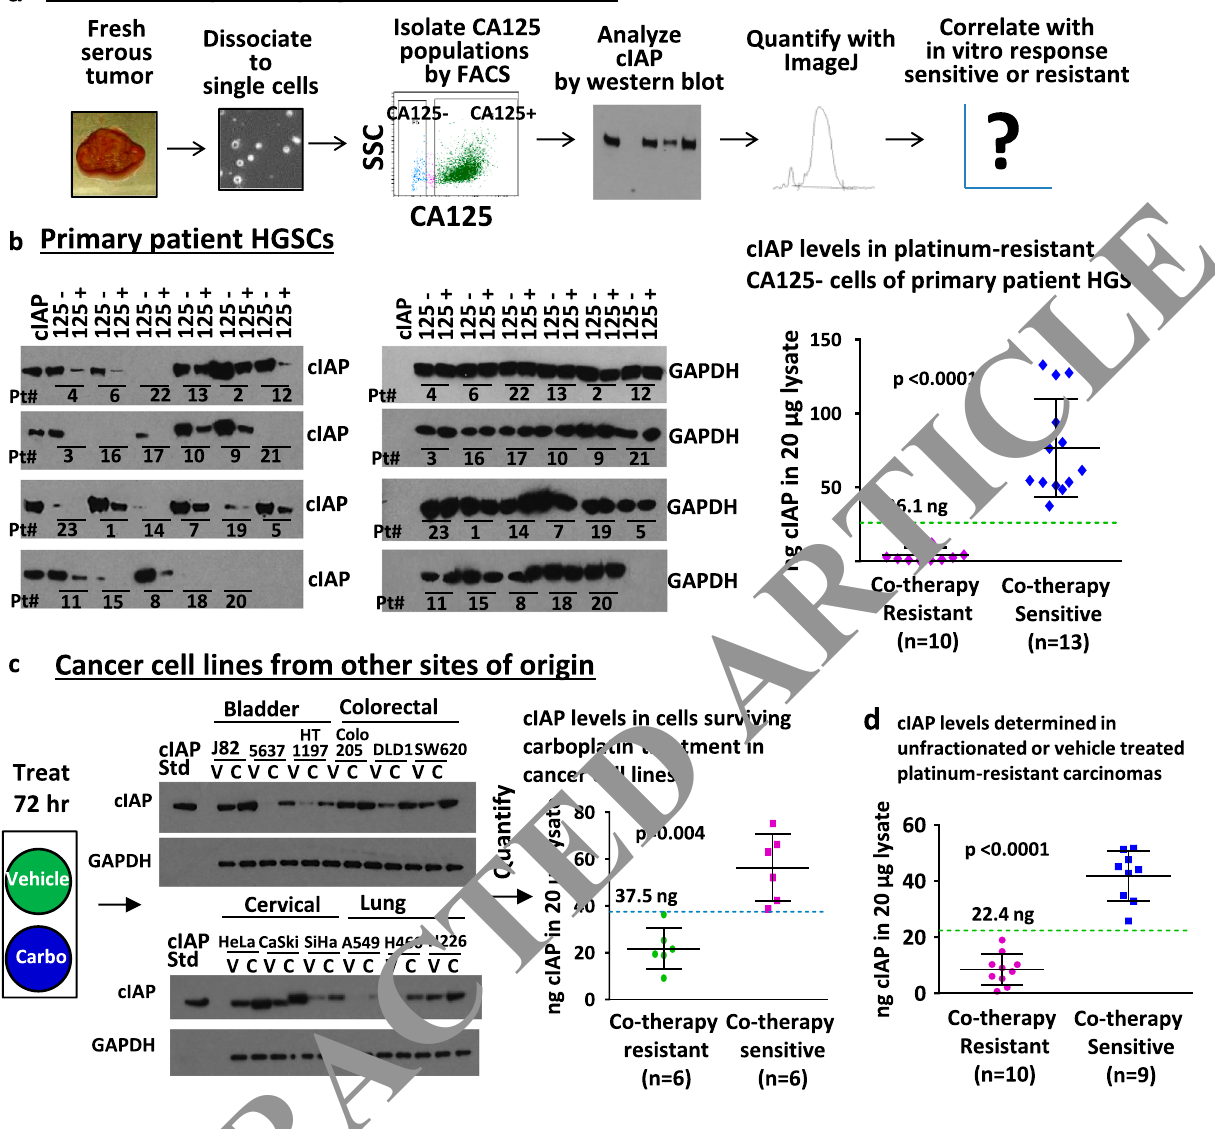
Fig. 3 Analysis of cIAP levels by western blot effectively segregated co-therapy sensitive vs. resistant HGSCs. a Schema for analysis of cIAP levels in HGSCs by semi-quantitative western blot and its correlation with co-therapy response. b cIAP protein levels were measured in 20 μ g of lysate from the CA125 negative and positive HGSC populations and compared with a 40 ng standard of cIAP1 and 2 (20 ng each) included on each blot. Glyceraldehyde 3-phosphate dehydrogenase (GAPDH) was used as a loading control. Levels of cIAP expression, quanti fi ed for each sample using ImageJ, were plotted against in vitro response to co-therapy. The expression of cIAP in the CA125 negative cells was signi fi cantly higher in co-therapy sensitive ( > 26.1 ng in 20 μ g lysate) compared with co-therapy resistant ( < 26.1 ng in 20 μ g lysate) HGSCs ( p < 0.0001). c Levels of cIAP expression were determined in platinum-resistant non-HGSC carcinoma cell lines. Cells were treated for 72 h with vehicle (as control) or carboplatin (to enrich for platinum-resistant cells). Signi fi cantly higher cIAP expression was observed after carboplatin treatment in co-therapy sensitive compared with co-therapy resistant cell lines (threshold midpoint 37.5 ng cIAP in 20 μ g cell lysate, threshold range 36.3 – 38.7 ng cIAP, p = 0.004). d Analysis of all platinum-resistant samples (HGSC and non-HGSC) demonstrates that cIAP levels in unfractionated or vehicle-treated tumor cells can segregate co-therapy sensitive ( n = 9) vs. co-therapy resistant ( n = 10) carcinomas in clinically de fi ned platinum-resistant disease (threshold midpoint 22.4 ng cIAP in 20 μ g cell lysate, threshold range 19.1 – 25.8 ng cIAP, 100% accuracy, p <